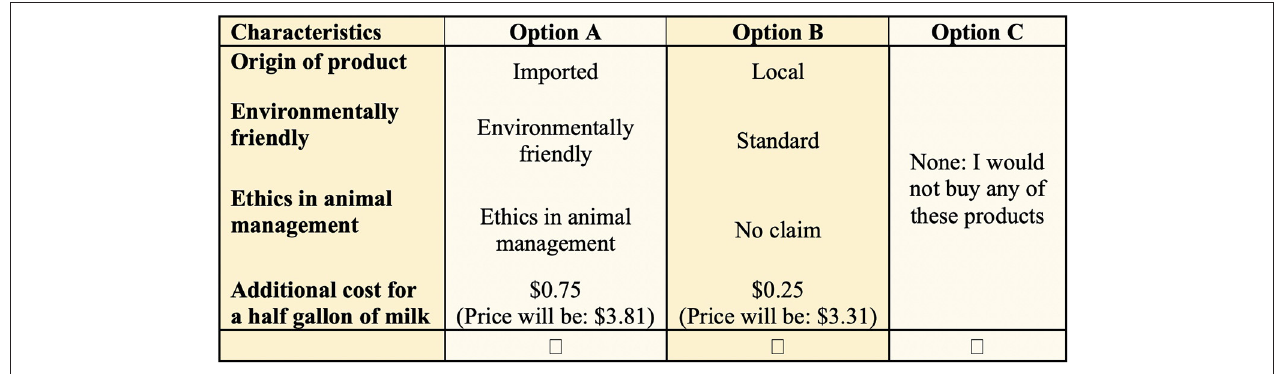
FIGURE 1 | Example of a choice set used in this study a . a Modified from Spanish